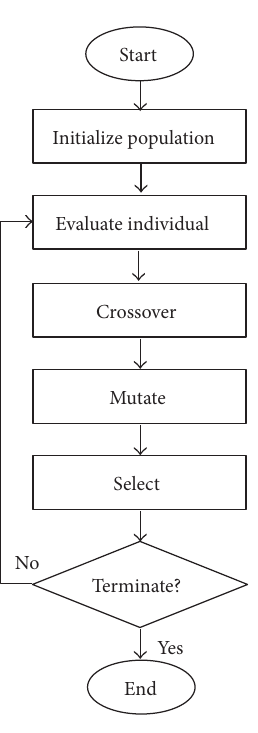
Figure 2: Evolutionary process of Evolutionary Fuzzy Neural Net-